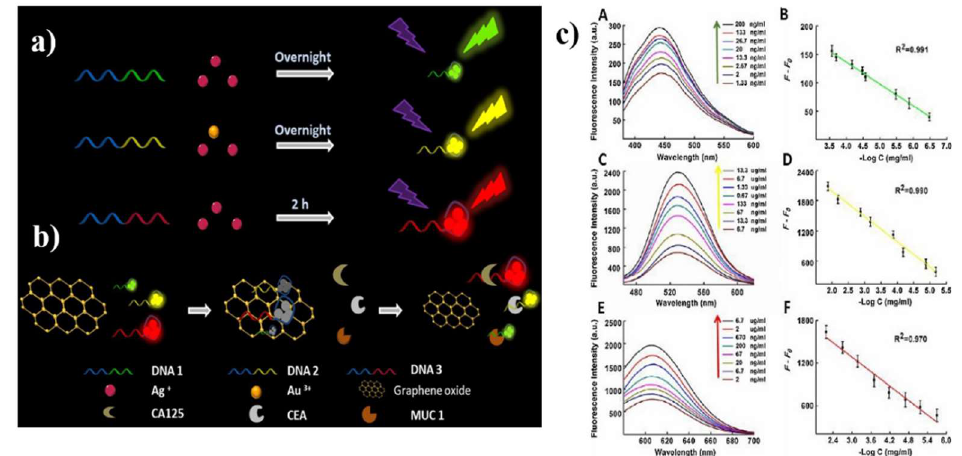
Figure 7. ( a ) Schematic illustration of synthesizing DNA-Ag NCs and DNA-Ag/Au NCs; ( b ) schematically demonstrating the mechanism for assaying MUC1, CEA and CA125; ( c ) fluorescence spectra of the assaying model in the presence of varying concentrations of MUC1 ( A ), CEA ( C ) and CA125 ( E ), the linear relationships between F-F0 and the concentrations of MUC1 ( B ), CEA ( D ) and CA125 ( F ), respectively. Reproduced from [120], with permission from Elsevier, 2018. Table 2. Summary of innovative optical biosensors for cancer biomarkers detection. Probe DNA aptamer GO